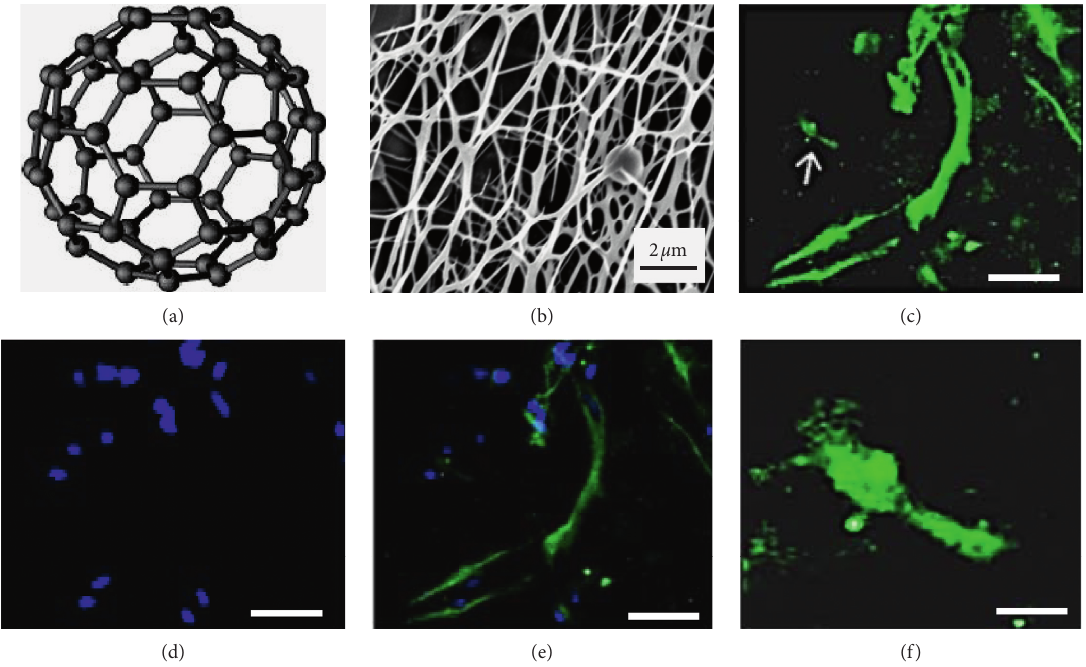
Figure 2: (a) Representation of C 60 fullerene [32]. (b) SEM images of PCL-fullerene nanoscaffolds fabricated by electrospinning. (c–e) Immunocytochemical micrographs of astrocytes cultures on the scaffolds and labeled with antiglial fibrillary acidic protein antibody (antiGFAP, green) and Hoechst dyes (blue, scale bar: 50 μ m). (f) Magnification images of cells pointed with an arrow in (c) (scale bar: 25 μ m) [31].